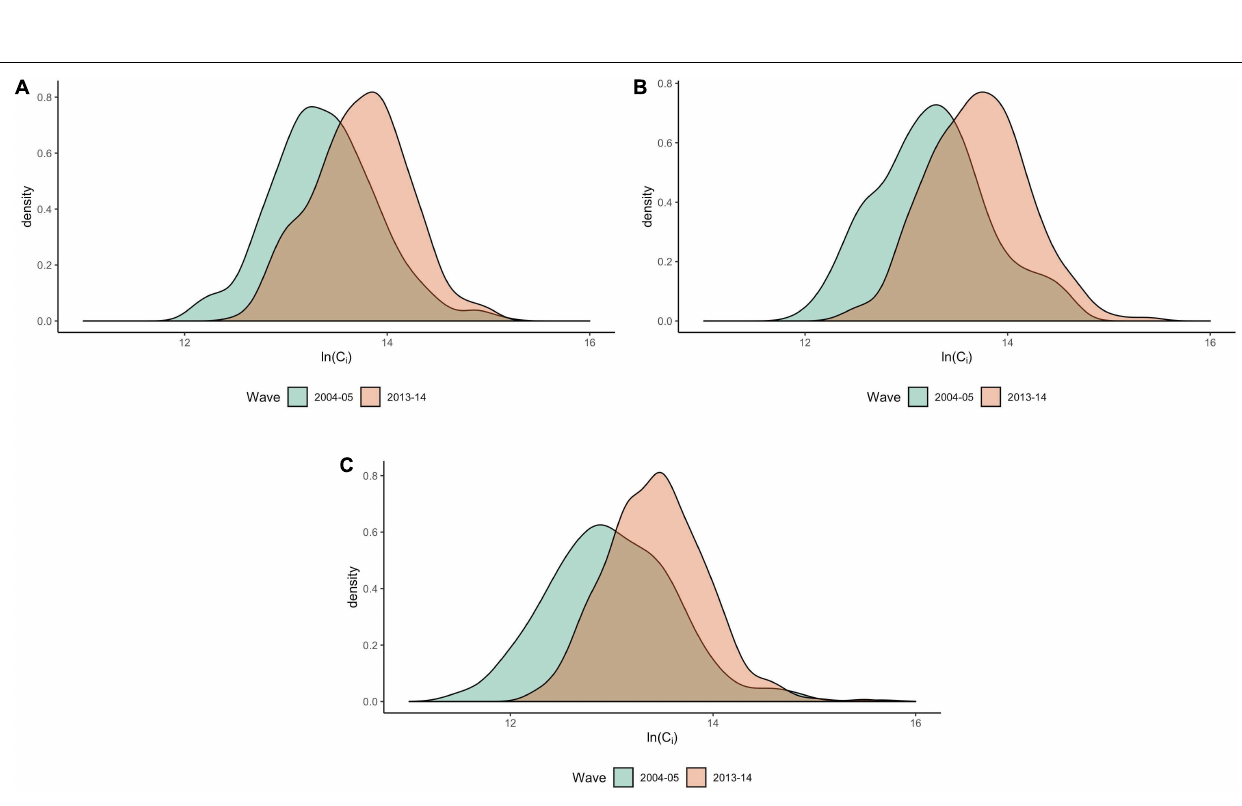
FIGURE 4 | Distribution of the log total annual household consumption per adult equivalent [in constant 2010 prices; Ugandan shillings (UGX$)] for the 2005–2006 and 2013–2014 survey waves for (A) households who increased the share of area allocated to trees on farms, (B) households who decreased the share of area allocated to trees on farms, and (C) households who did not change the land allocated to trees on farms or did not have trees on farms. For (A) : mean 2004–2005 = 60,307.84 UGX$; mean 2013–2014 = 82,364.55 UGX$; diff = 22,056.71; diff t -test = 9.3473***. For (B) : mean 2004–2005 = 57,388.2 UGX$; mean 2013–2014 = 81,688.83 UGX$; diff = 24,300.59; diff t -test = 7.5104***. For (C) : mean 2004–2005 = 46,135.97 UGX$; mean 2013–2014 = 62,166.61 UGX$; diff = 16,030.64; diff t -test = 6.2985***. n = 1,395 rural households. Brown color shows overlap between two survey waves. Data source: UNPS 2005–2006 and